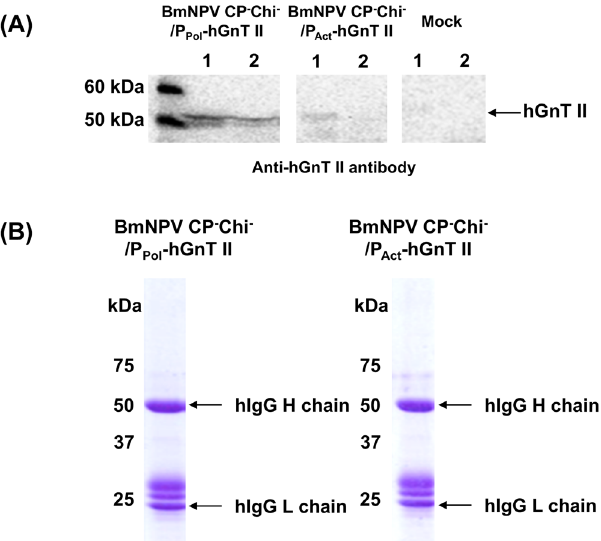
Figure 2. Expression of recombinant proteins in silkworm pupae with coexpression of hGnT II. ( A ) Expression of hGnT II using BmNPV CP − Chi − /P Act -hGnT II or BmNPV CP − Chi − /P Pol -hGnT II in silkworm pupae. Pupae were homogenized with TBST and centrifuged to separate the supernatant from the insoluble material. Western blotting was performed on both fractions. Lane 1: Supernatant, lane 2: Pellet. ( B ) SDS-PAGE with CBB staining using hIgG purified from BmNPV CP − Chi − /29IJ6 hIgG-injected silkworm pupae. The left and right panels show the proteins that were coexpressed with hGnT II under the control of either the polyhedrin (P pol -hGnT II) or actin A3 promoter (P Act -hGnT